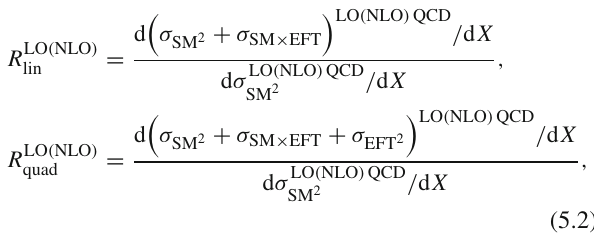
, M inv ) at LO and NLO QCD accuracy. In (with X = p max ll T , l the R NLO ratios the NLO QCD corrections to the dia- lin ( quad ) grams involving the aTGCs are included as well. For the Wilson coefficients we use the values listed in Eq. (3.11). In Figs. 7 and 8 only one Wilson coefficient is different from zero for each curve. Since the t -channel single-top contribu- tion is subtracted in the experimental searches for aTGCs, in Figs. 7 and 8 the contribution of the processes with initial- state b quarks is not included. Without these processes the NLO QCD corrections become of order − 60 and − 70% for (cid:9) 500 GeV and M inv (cid:9) 1 . 2 TeV: we thus limit our p max ll T , l analysis to the p max and M inv values below 500 GeV and ll T , l 1 . 2 TeV, respectively, since for larger transverse